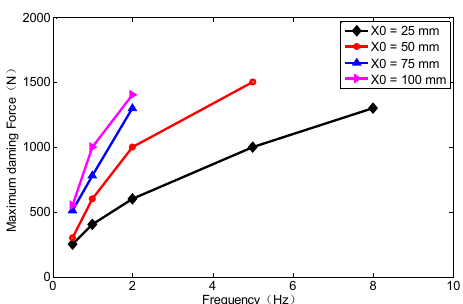
Figure 6. E ff ects of frequency on the maximum damping force. (Reprinted (adapted) with permission Figure 6. Effects of frequency on the maximum damping force. (Reprinted (adapted) with from Ref. [61] Copyright (2019) permission from Ref. [61] Copyright (2019) Elsevier]).